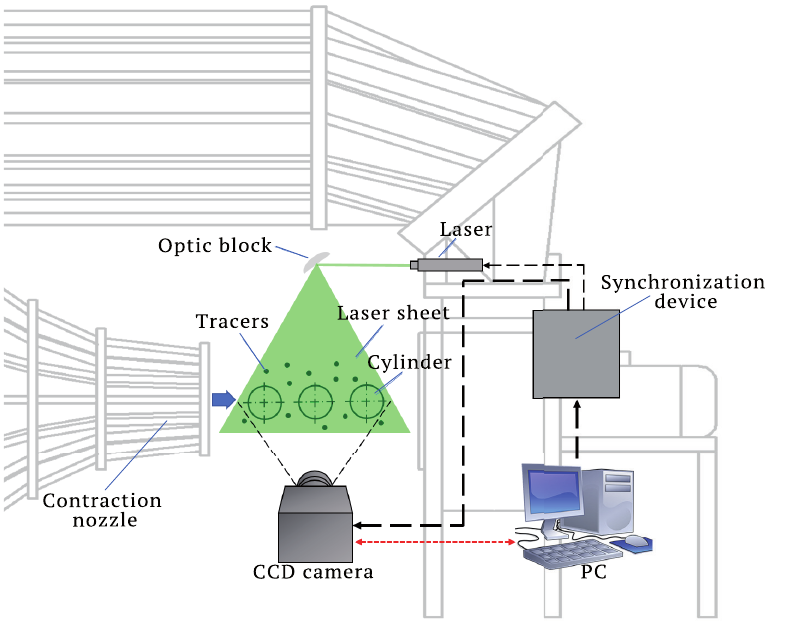
Figure 4. Diagram of the experimental PIV